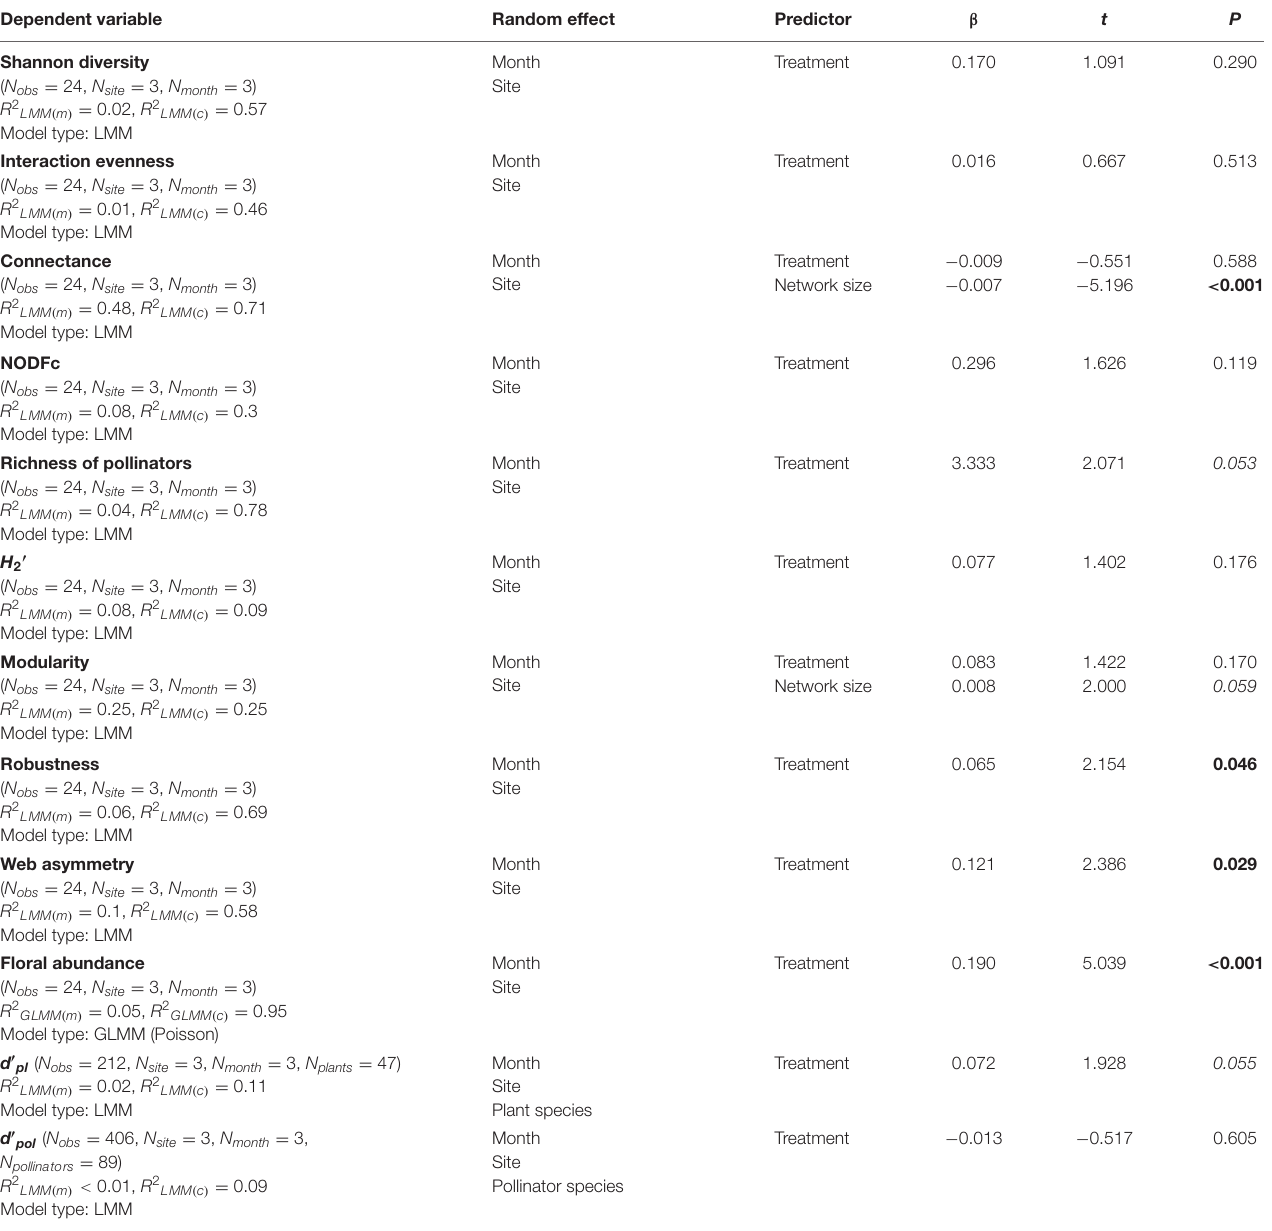
TABLE 1A | LMMs and GLMMs with Poisson distribution explaining the effects of treatment (grazed versus ungrazed) on plant–pollinator communities and network structure. Dependent variable Random